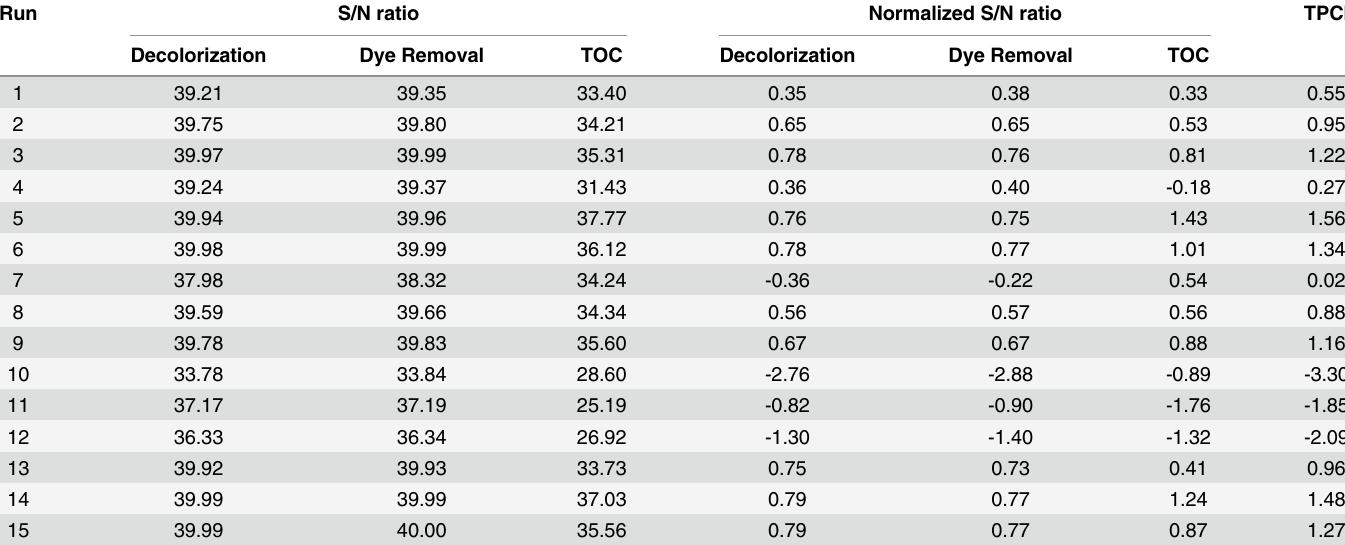
Table 7. The obtained S/N ratios, normalized S/N ratios, and TPCI values for run 1 to 15. Run